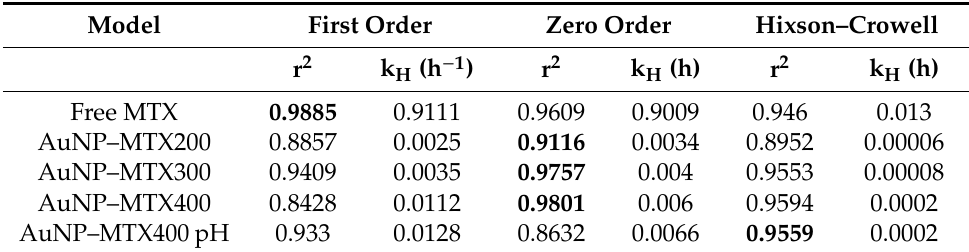
Table 1. Calculated parameters and correlation coe ffi cients (r 2 ) of di ff erent models of release kinetics